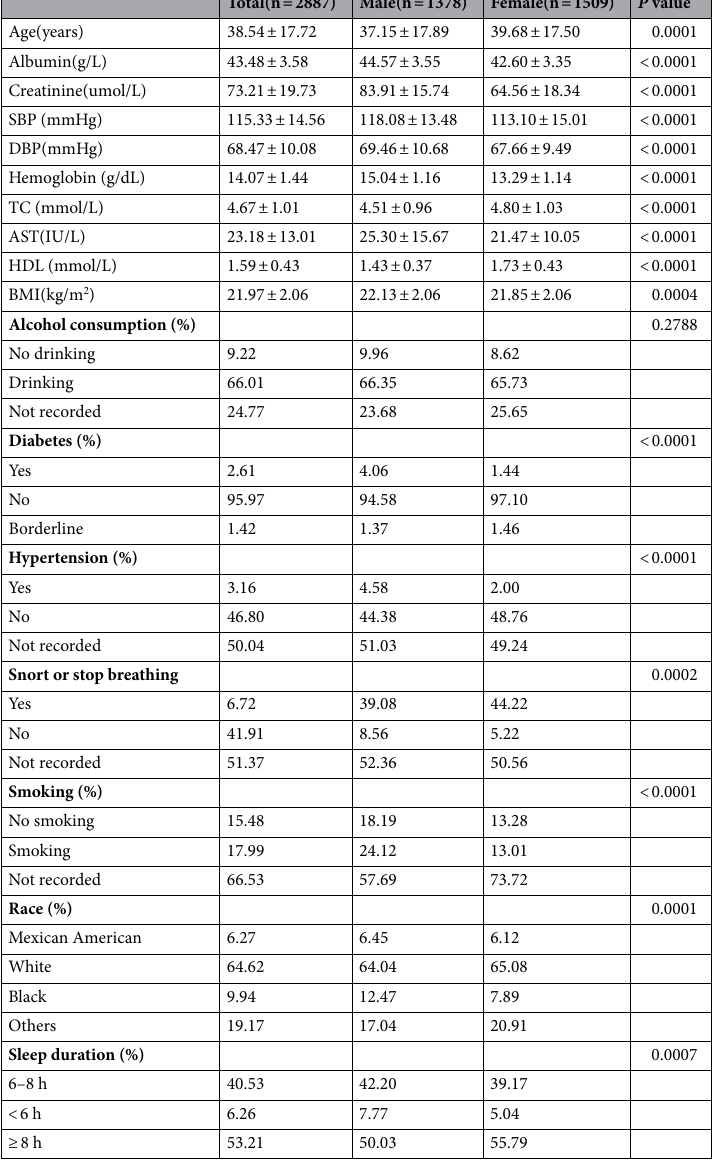
Table 1. General characteristics of 2887 participants included in the present study. Mean +/− SD for: continuous variables. P value was calculated by weighted linear regression model. % for: categorical variables P value was calculated by weighted chi-square test. SBP systolic blood pressure, DBP diastolic blood pressure, TC total cholesterol, BMI body mass index, AST aspertate aminotransferase, HDL high-density